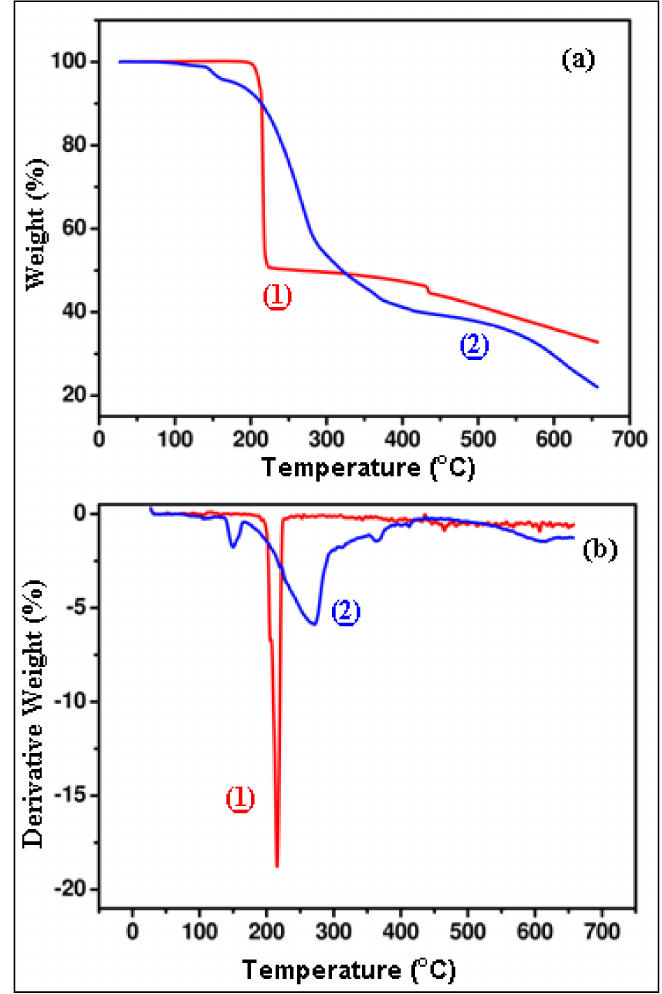
Figure 17. TGA ( a ) and DTG ( b ) curve of complexes ( 1 ) and ( 2